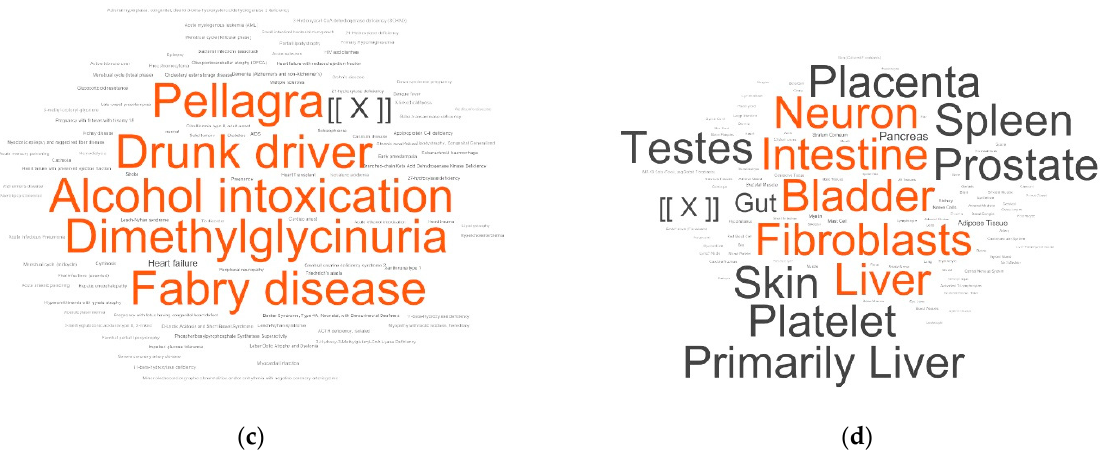
Figure 4. The laboratory-developed test (LDT) outputs for a person with Parkinson’s disease (PD). The LDT outputs for the overrepresentation pattern in disease-associated metabolite sets ( a ), pathway-associated metabolite sets ( b ), metabolite sets associated with abnormal concentrations ( c ), and location-based metabolite sets ( d ). [[X]] is a marker corresponding to a representation score of 50. The overrepresented metabolite sets with the top five scores are colored in red.